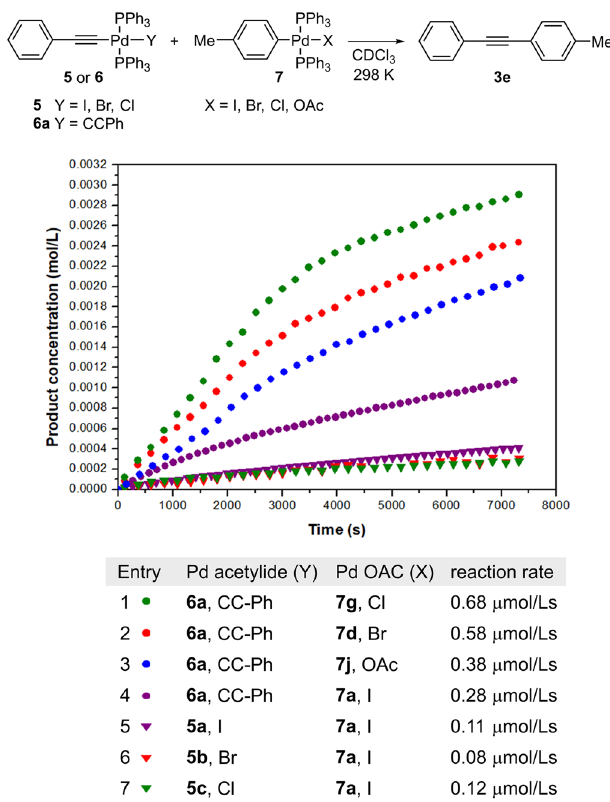
Fig. 7 Investigating the in fl uence of ligands in complexes 5 and 7 on the rate of the transmetallation reaction. Conditions: 5 or 6a (0.01 M), 7 (0.01 M), CDCl 3 , 302